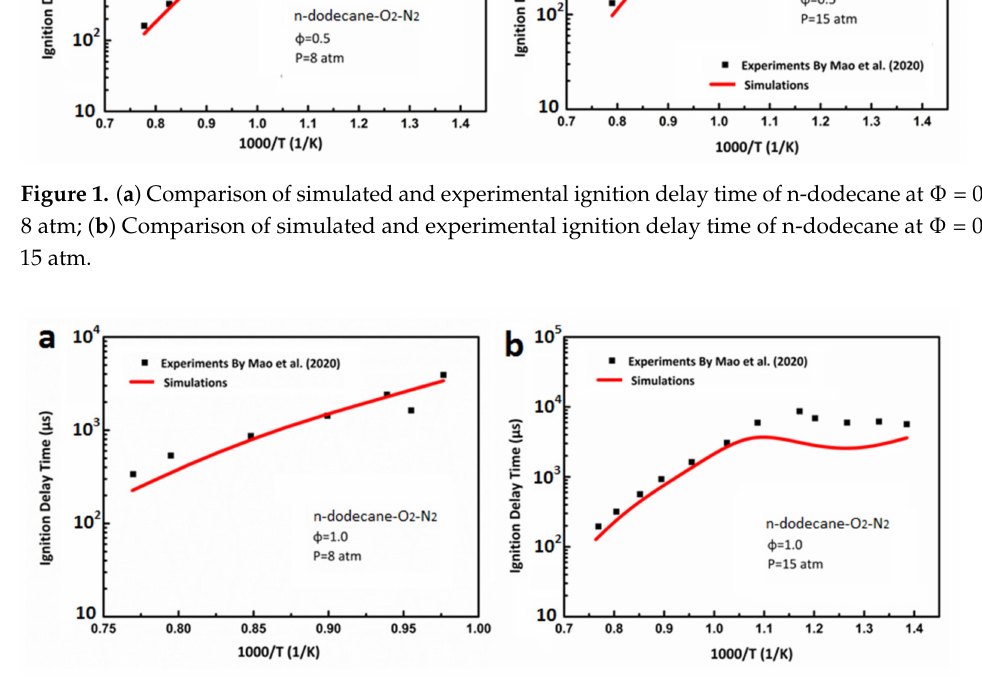
Figure 2. ( a ) Comparison of simulated and experimental ignition delay time of n-dodecane at Φ = 1.0, 8 atm; ( b ) Comparison of simulated and experimental ignition delay time of n-dodecane at Φ = 1.0, 15